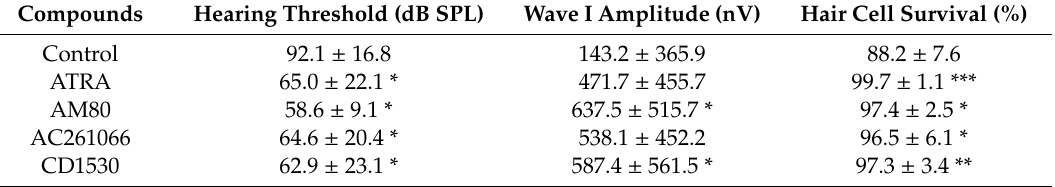
587.4 ± 561.5 * 97.3 ± 3.4 ** Hearing threshold and wave I amplitude are the results from auditory brainstem response by click stimulation in post-noise 1 day. Statistical analyses were performed in comparison to the control group. * p < 0.05; ** p < 0.01; *** p < 0.001.